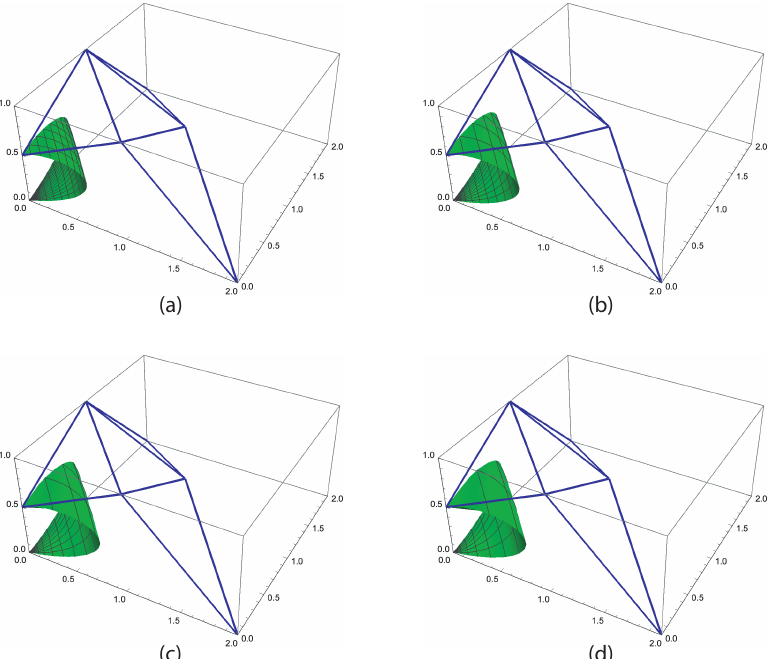
Figure 5: The truncated triangular Meyer-König-Zeller surfaces with ( m = 2, n = 1) (a), ( m = 2, n = 3) (b), ( m = 2, n = 6) (c), ( m = 2, n = 9)